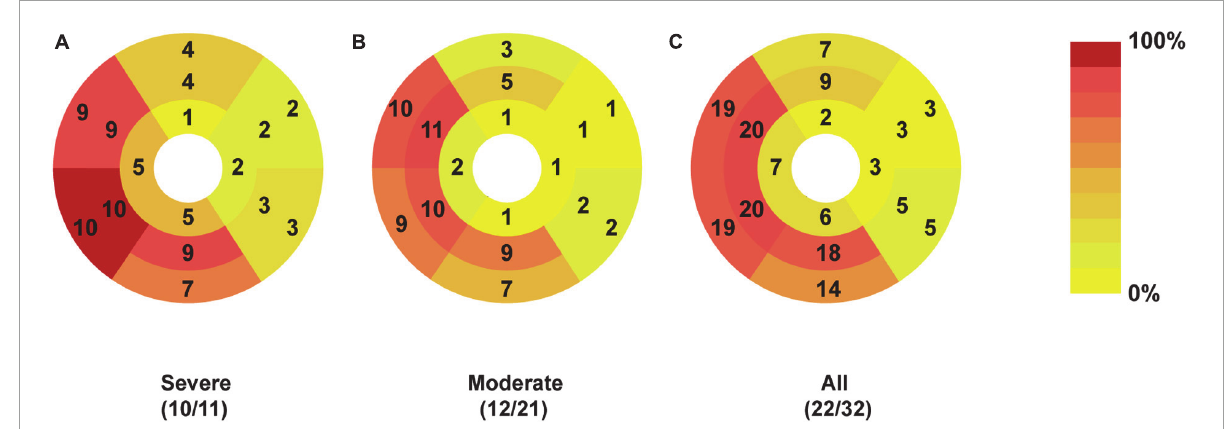
FIGURE3 Dominant location and distribution of myocardial LGE segments in patients recovered from COVID-19. The number and frequency of myocardial LGEs based on the AHA 16 segments’ model in patients with severe (A) , moderate (B) , and all (C) COVID-19 were displayed. There were 32 patients enrolled, including 11 patients with severe and 21 patients with moderate COVID-19. Moreover, positive LGEs were found in 22 patients, including 10 patients with severe COVID-19 and 12 patients with moderate COVID-19. AHA, American Heart Association; COVID-19, Coronavirus Disease-2019; LGE, late gadolinium enhancement.